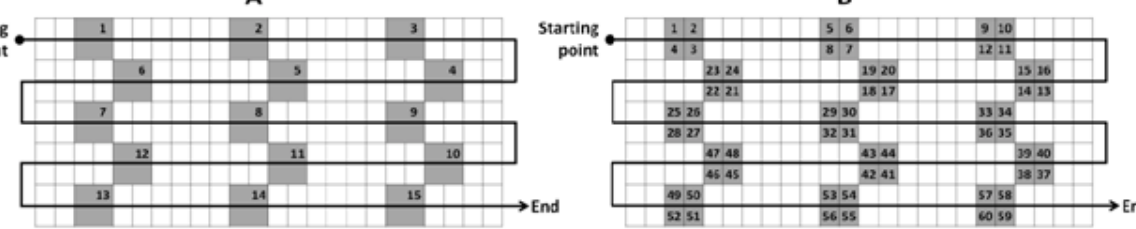
Figure 1. Location of the eight citrus groves (A-H) in Taranto Province of Southern Italy, where the in- cidence of Citrus tristeza virus was monitored for the present study.